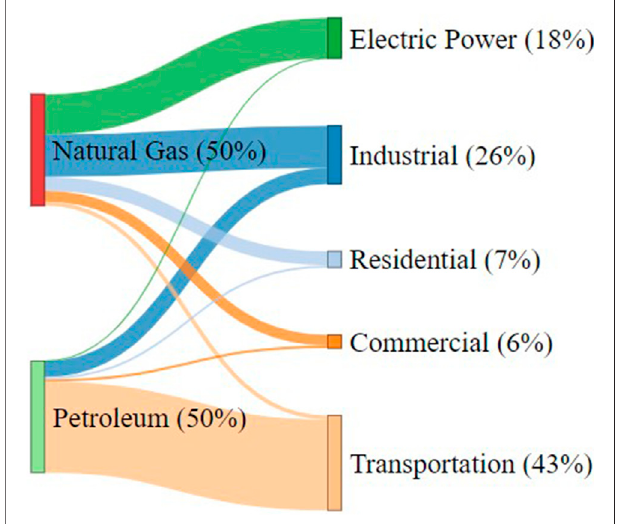
FIGURE 5 | Energy consumption by various end use sectors of New Mexico in